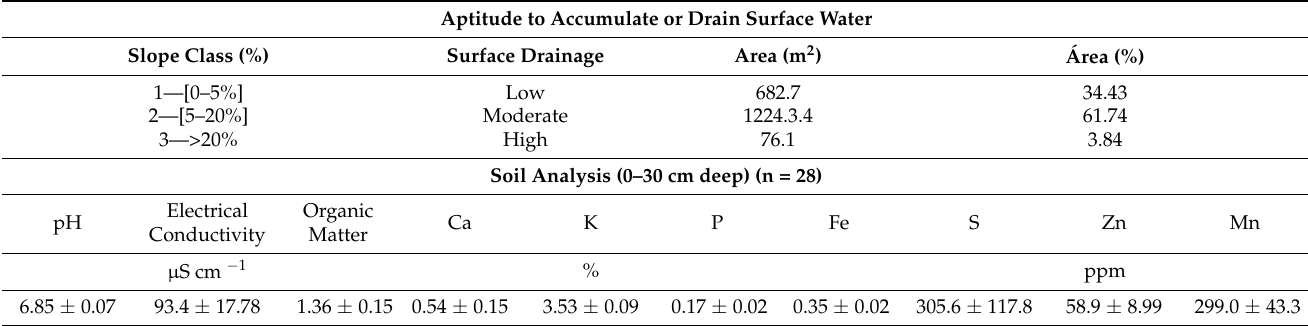
Table 1. Characterization of soil (at 0–30 cm deep) in the vineyard of Lau Velho field. Aptitude to Accumulate or Drain Surface